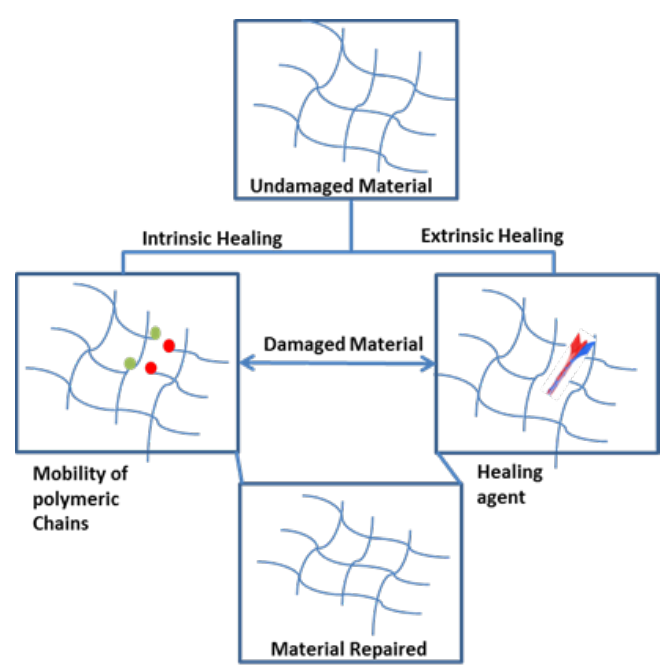
Figure 9. Distinction between extrinsic and intrinsic self-repairing materials. The concept has been redesign on the basis of ref. [81].